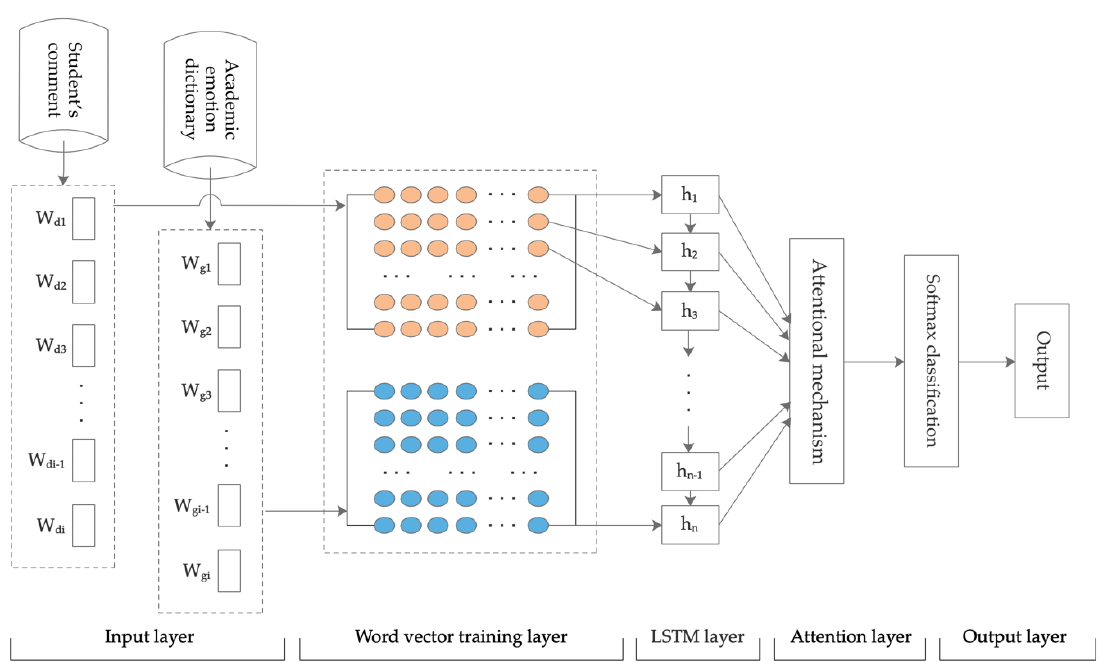
Figure 4. The long short-term memory with attention mechanism (LSTM-ATT) network model.